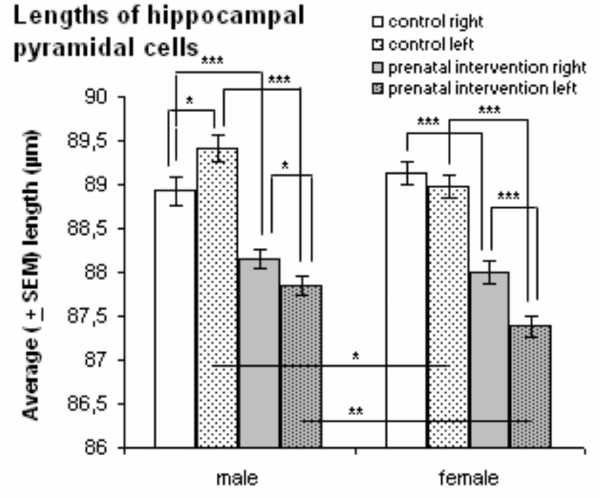
Figure 5 - Length of the pyramidal cells of the hippocampus. Average (± SEM) length of the pyramidal cells in area CA3 of the right and left hippo- campi of male (n = 12) and female (n = 14) controls and male (n = 16) and female (n = 14) animals with prenatal intervention was determined. Male and female prenatal intervention rats had significantly shorter cell lengths in both their right and left hippocampi compared to controls. Cells in right hemispheres of male and female prenatal intervention groups were signifi- cantly longer than those in left hemispheres. Male controls had significantly longer cells on the left side. Female controls had shorter cells in the left hippocampus, but this difference was not significant. With the exception of cell lengths on the right hippocampal side of male and female controls, cells in the hemispheres of males were longer than the respective cells in female animals. Compared to the left hemisphere, differences between right hemispheres of male and female controls and prenatal intervention groups were not significant. *p ≤ 0.05, **p ≤ 0.006 and ***p ≤ 0.0004. onset of the illness, future male schizophrenic patients (16-17 years old) weighed less than the rest of the cohort.